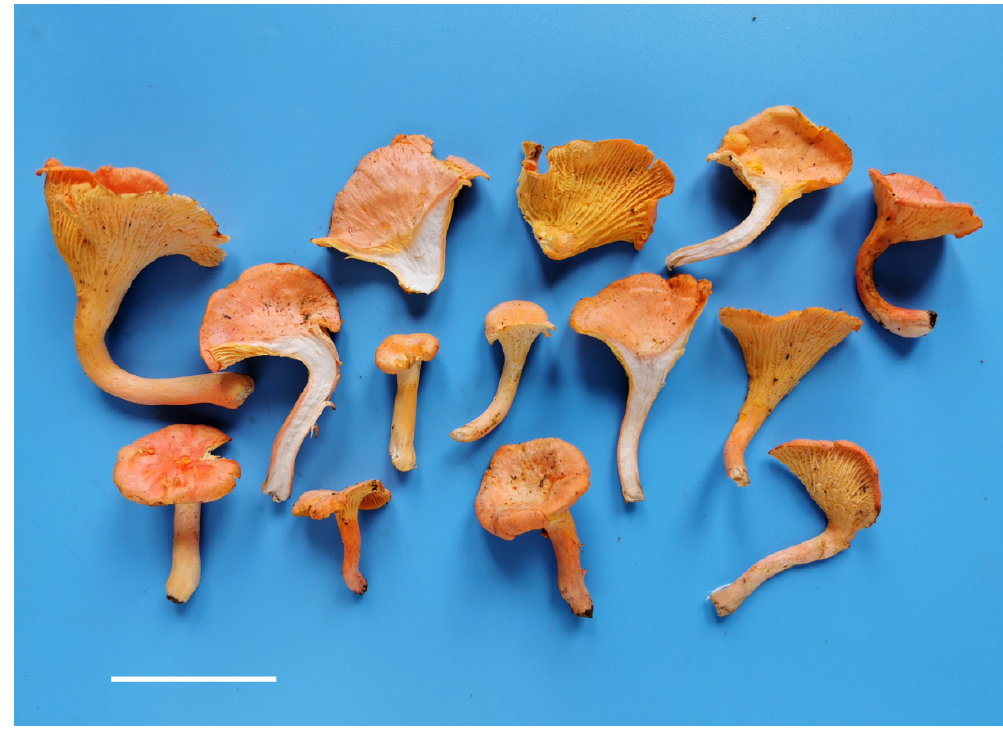
Figure 10. Basidiomata of Cantharellus phloginus (GDGM79007). Bar = 5 cm.